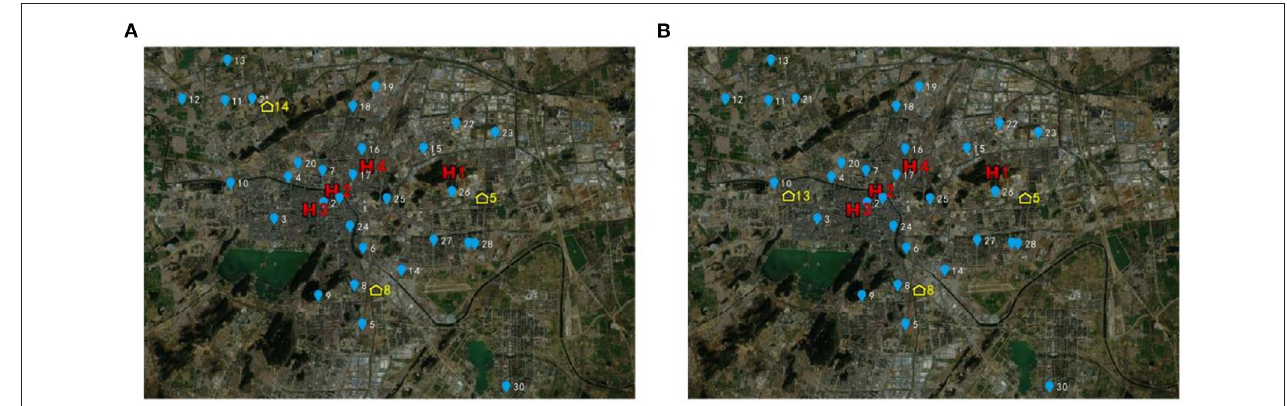
FIGURE 7 | Location results based on the proposed models (A) based on model 1 (B) based on model